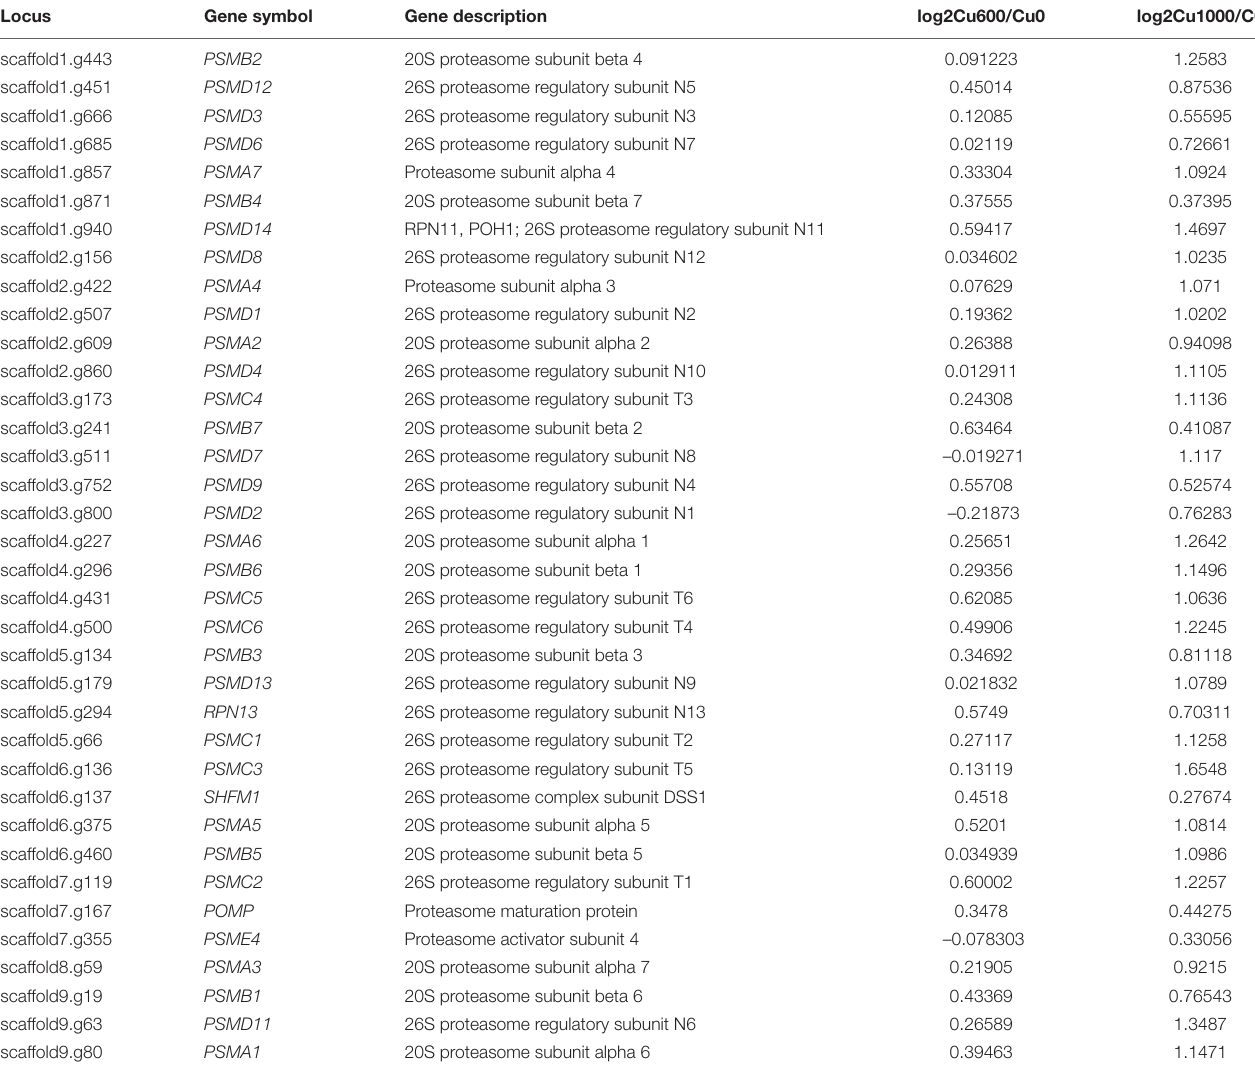
TABLE 4 | Differentially expressed genes involved in proteasome metabolism (KEGG: pgu03050) in the Cu-600 and Cu-1000 groups.